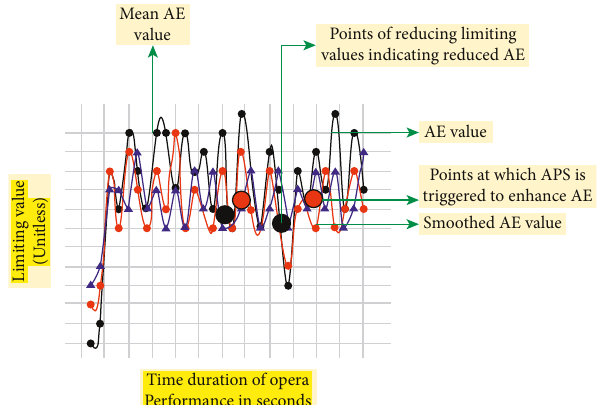
Figure 4: Enhancement of AE for opera performance-based